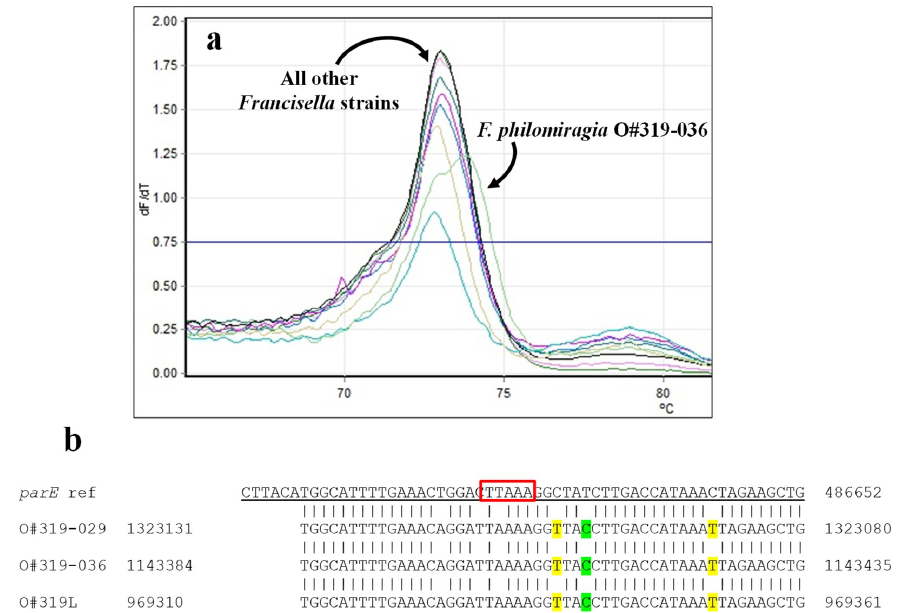
Figure 5. HRMA— Francisella spp. parE . ( a ) Melt curves for Francisella spp. parE amplicons. ( b ) Comparison of reference parE sequence with published sequences for the F. philomiragia strains (see Table 9). All F. tularensis strains tested are 98% identical to the reference sequence within this locus. Primer sequences are underlined. The sequence within the red box indicates the 5-nt deletion of interest [34]; mutations/substitutions predicted to increase or decrease amplicon T m s are highlighted in green or yellow, respectively.